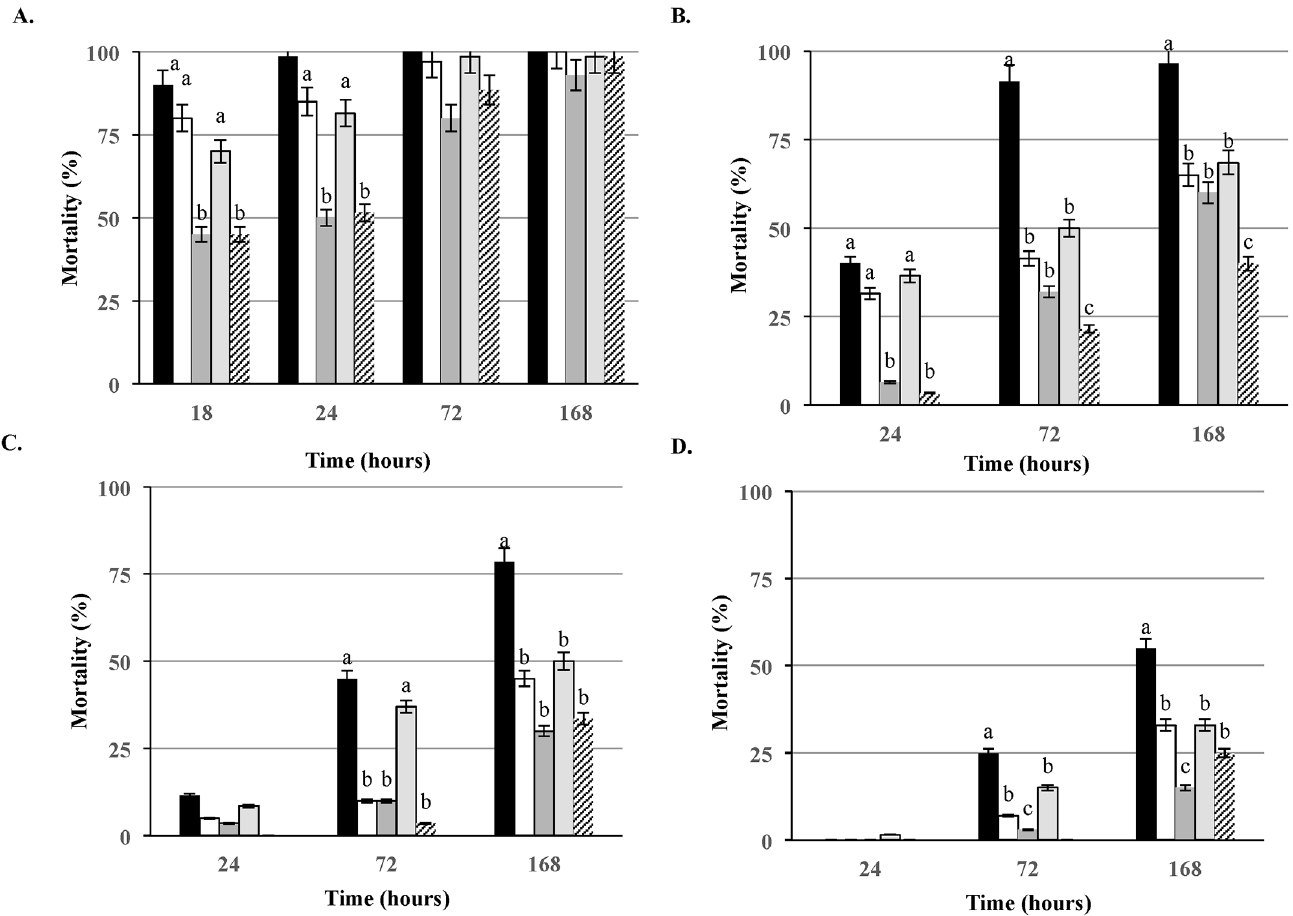
Fig 1. Comparison of virulence of different Listeria spp. in Galleria model. Larvae were infected with L . monocytogenes LS1209(designated with black square)along with L . innocua LS9 (designatedwith white square), L . welshimeri LS166(designatedwith dark gray square), L . ivanovii LS4 (designatedwith gray framed square) and L . seeligeri LS6 (designated with dark upward diagonalsquare) at the doses of (A) 10 7 CFU/larva (B) 10 6 CFU/larva, (C) 10 5 CFU/larva (D) 10 4 CFU/larva. a > b > c (P < 0.05)LT 50 presents time necessaryto kill 50% of larvae. Presentedresults are averageof three independent